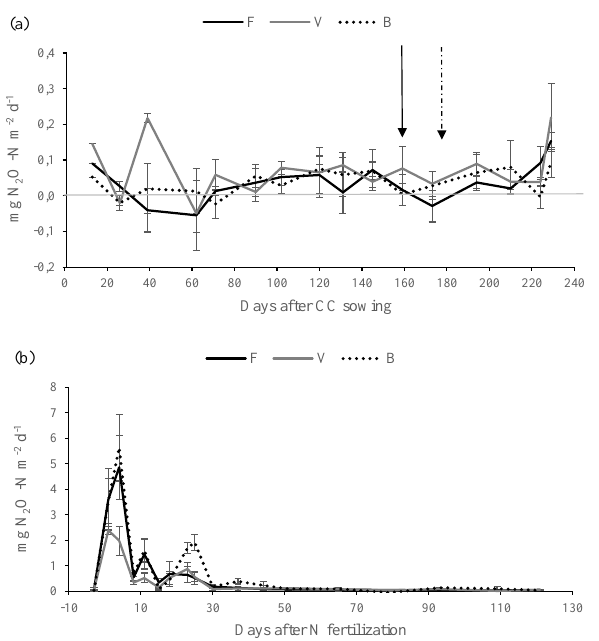
Figure 3. N 2 O emissions for the three CC treatments (fallow, F; vetch, V; and barley, B) during Period I (a) and II (b) . The black arrows indicate the time of spraying glyphosate over the CCs. The dotted arrows indicate the time of maize sowing. Vertical lines indi- cate standard errors.